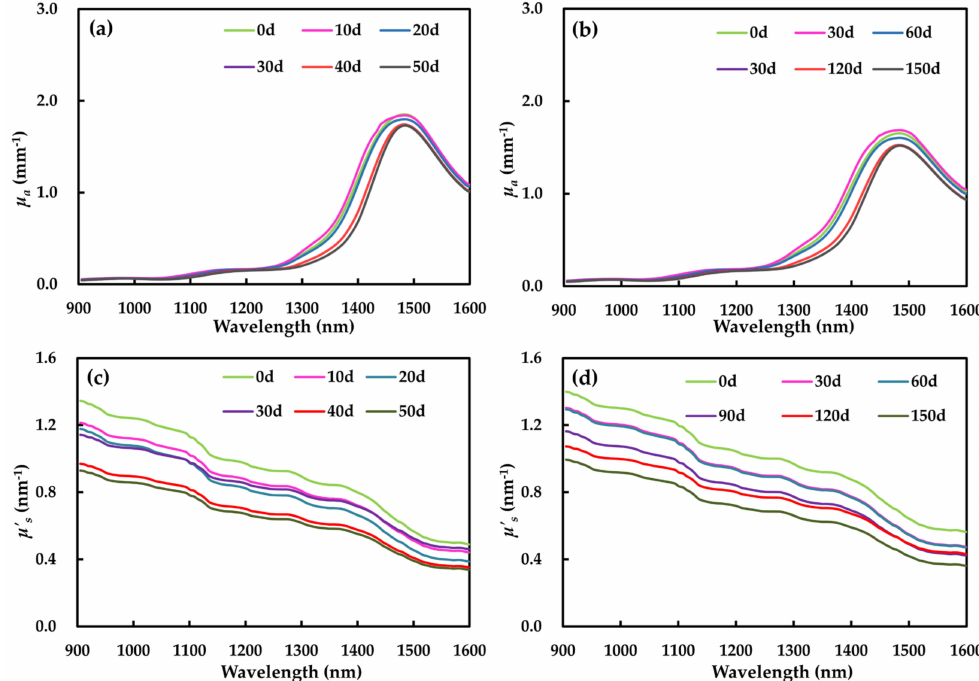
Figure 3. Average optical properties of Fuji apple flesh for six storage times: absorption ( µ a ) and scattering ( µ (cid:48) s ) at 25 ◦ C ( a , c ); absorption ( µ a ) and scattering ( µ (cid:48) s ) at 0 ◦ C ( b , d ). d,